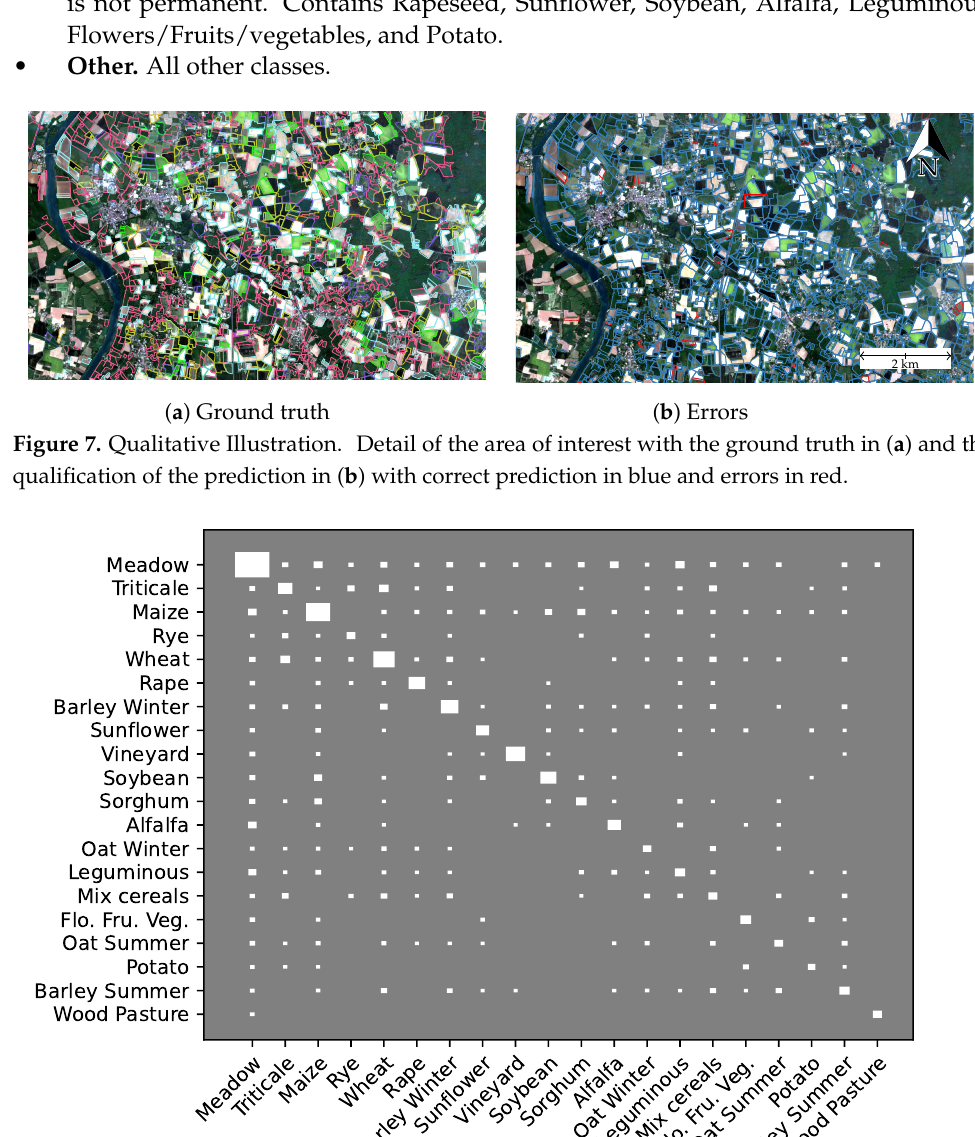
Figure 8. Confusion Matrix. Confusion matrix of the prediction of of each entry corresponds to the square root of the number of